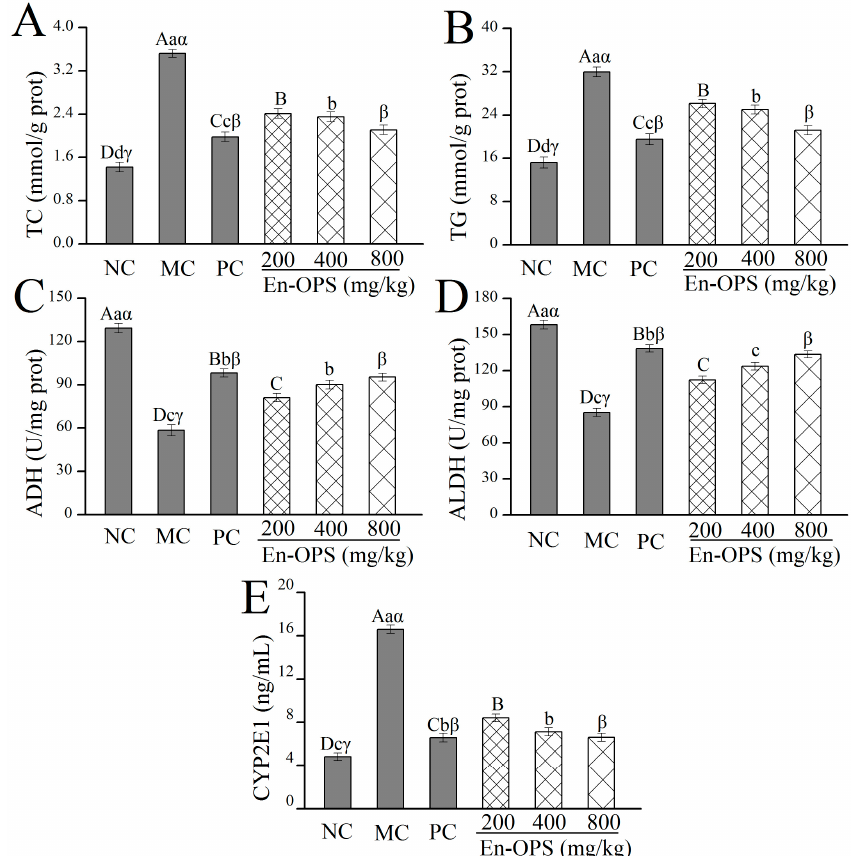
Figure 4. Effects of En-OPS on lipid levels and enzymic activities in liver of mice. ( A ) total cholesterol levels; ( B ) triacylglycerols levels; ( C ) alcohol dehydrogenase activities; ( D ) aldehyde dehydrogenase activities; and ( E ) cytochrome P450 2E1 levels. The values were reported as the mean ± S.D. of 10 mice per group. Bars with different letters were significantly different ( p < 0.05). The statistical significance of the differences between the groups were analyzed using Tukey’s tests in the software package (SAS 9.3). A value of p < 0.05 was regarded as statistically